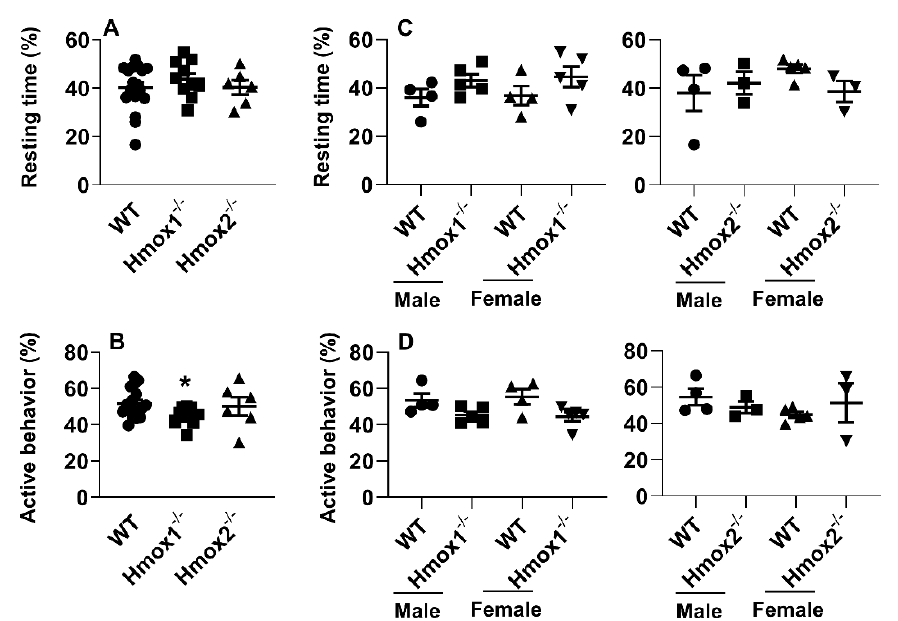
Figure 2. Physical activity was reduced in Hmox1 - / - but not in Hmox2 - / - mice. Physical activity was assessed in Hmox1 - / - , Hmox2 - / - mice and their WT littermates (4–5 months old) using continuous home cage video monitoring. ( A , C ) Percentage of resting time was calculated. ( B , D ) The sum of walking, hanging, grooming, and rearing was recorded as active behavior. Data are expressed as mean ± SEM. n = 6–10. * p < 0.05 vs. corresponding WT group.